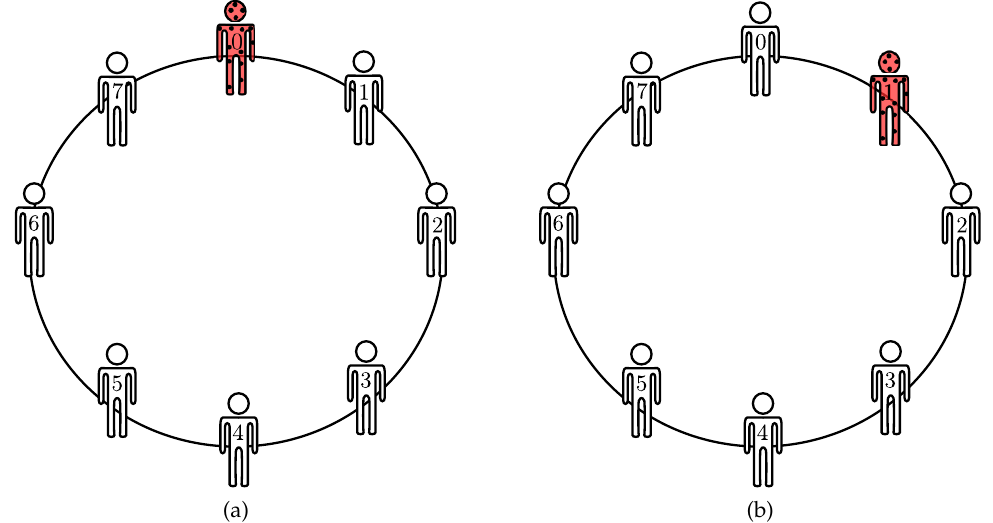
Figure 4. Regular graph in circular representation for N = 8 and single infected agent (red dotted). ( a ) The infected agent lies at node k = 0. ( b ) Graph obtained from cyclic permutation of nodes k → k + 1 and N − 1 → 0. Connections remain